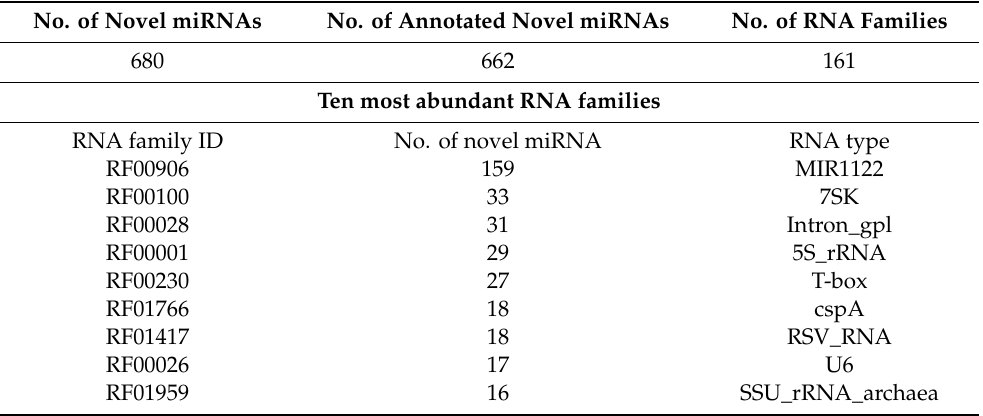
Table 2. Most abundant miRNA families in three barley genotypes under BYDV infection and healthy